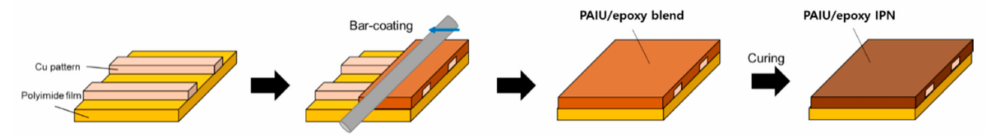
Figure 6. A schematic of the fabrication of a FPCB containing a PAIU/epoxy IPN as a